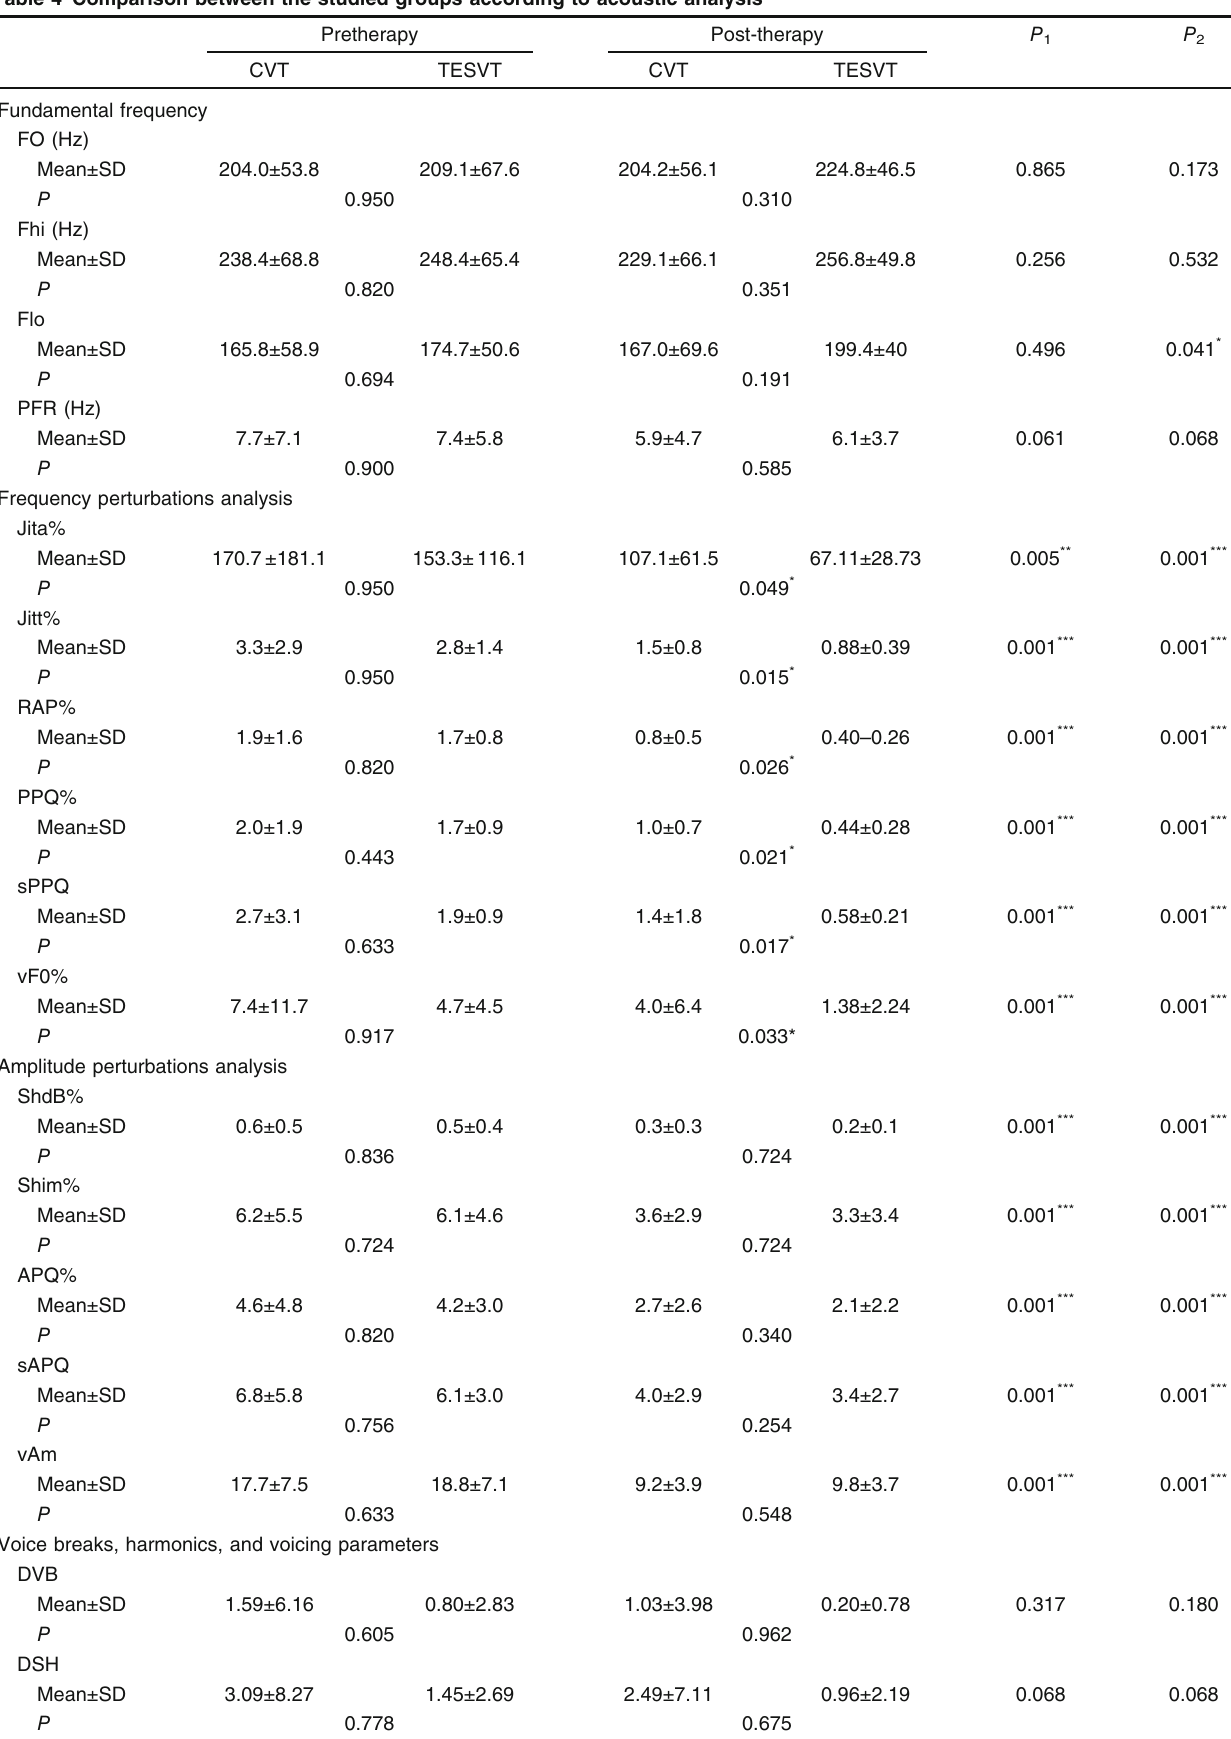
Table 4 Comparison between the studied groups according to acoustic